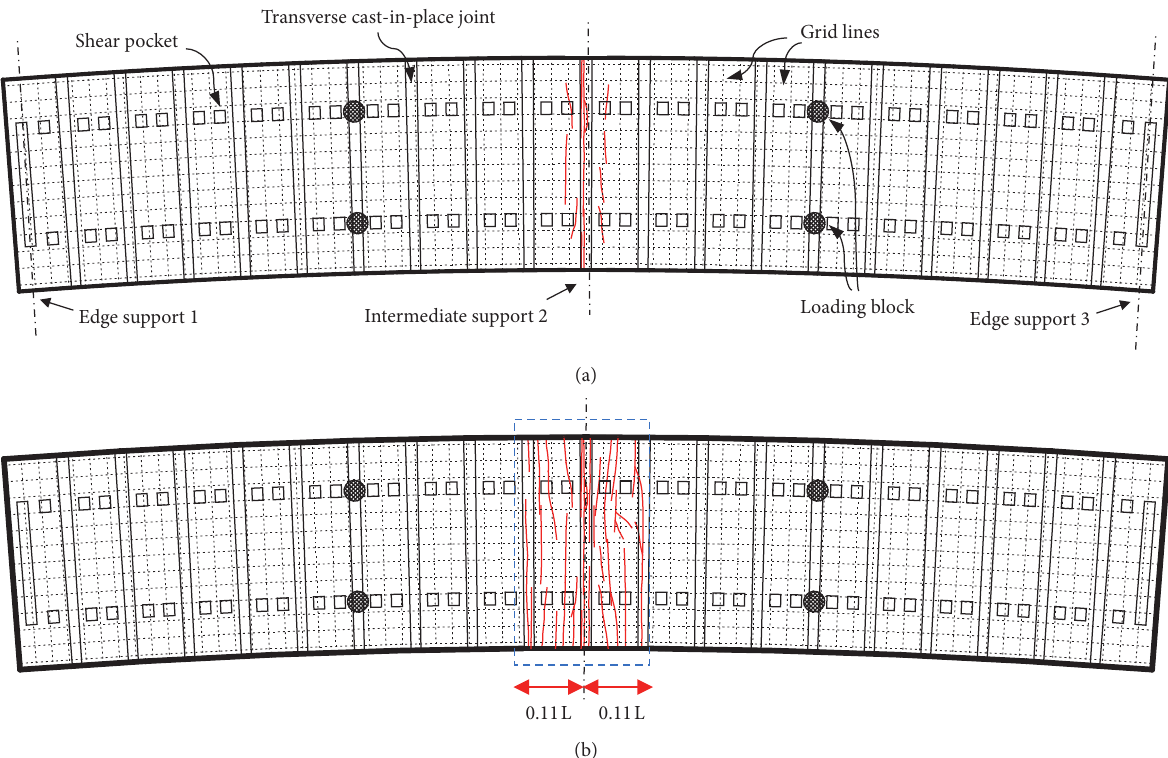
Figure 15: Schematic diagram of the concrete slab cracking process and distribution. (a) Cracking distribution under 140kN loading force. (b) Cracking distribution under ultimate